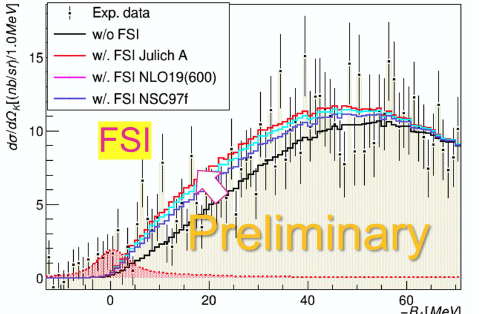
Figure 2. The in fl uence factor depending on a relative Λ n momentum in each theoretical model. The in fl uence factor is composed of four spin states, a singlet ( I s ) and triplet ( I t ) states with a ratio of one to three.